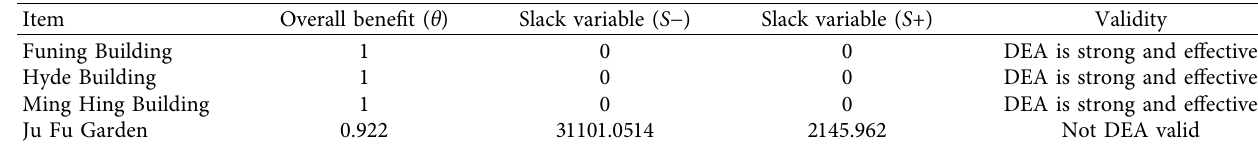
Table 7: Efectiveness analysis of Macau urban renewal site selection beneft based on EAD.